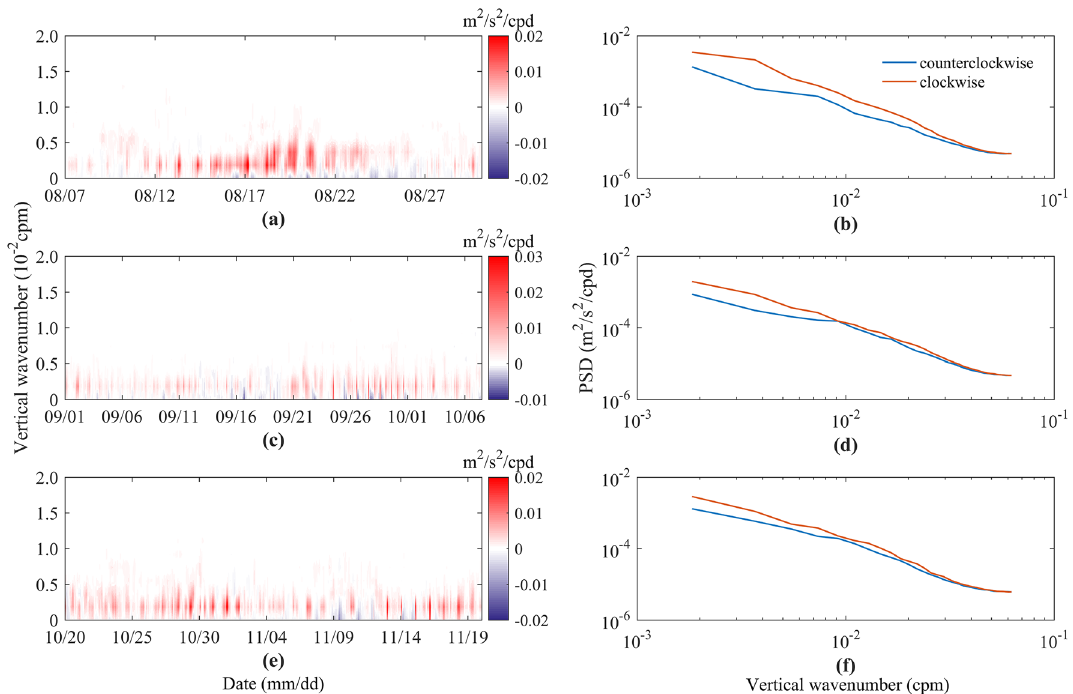
Figure 7. Rotary vertical wavenumber difference between clockwise and counterclockwise components and time-averaged rotary vertical wavenumber spectra during the passage of typhoons ( a,b ) Bebinca, ( c,d ) Barijat and Mangkhut, and ( e,f ) Yutu. The blue and orange solid lines represent the time-averaged counterclockwise and clockwise rotary components, respectively. cpm stands for “cycles per